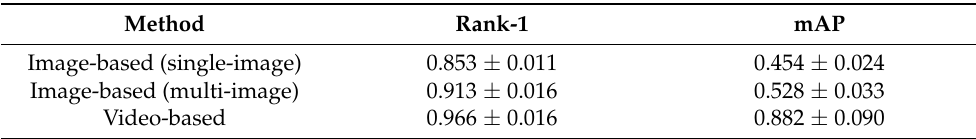
Table A2. Performance of the image-based, improved image-based and video-based re-ID approach. The rank-1 score, as well as the mean average precision (mAP), is given as a mean result of all runs of the five-fold cross-validation, including the overall standard